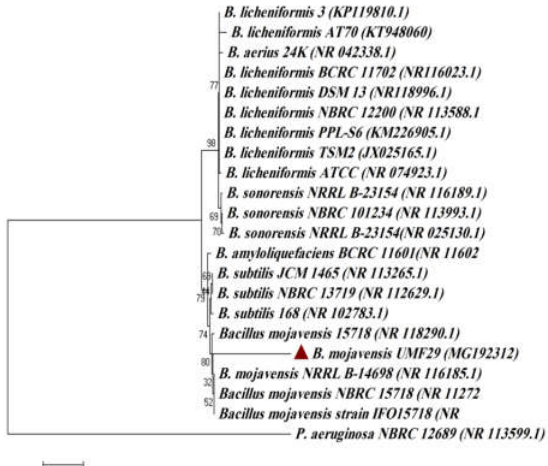
Fig. 2. The clear zone around the colony of strain UMF29 on the starch agar plate.